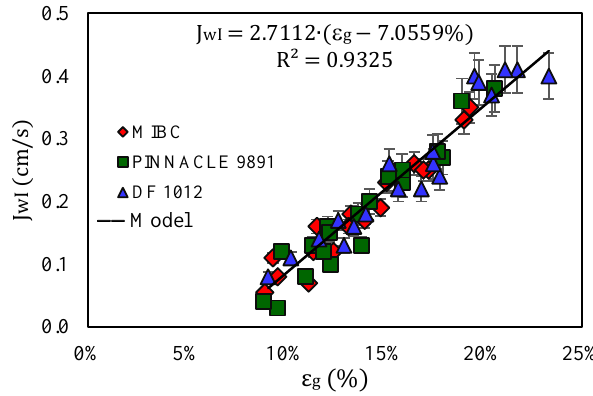
Figure 3. Water rate into the froth as a function of gas holdup for the three frothers tested.